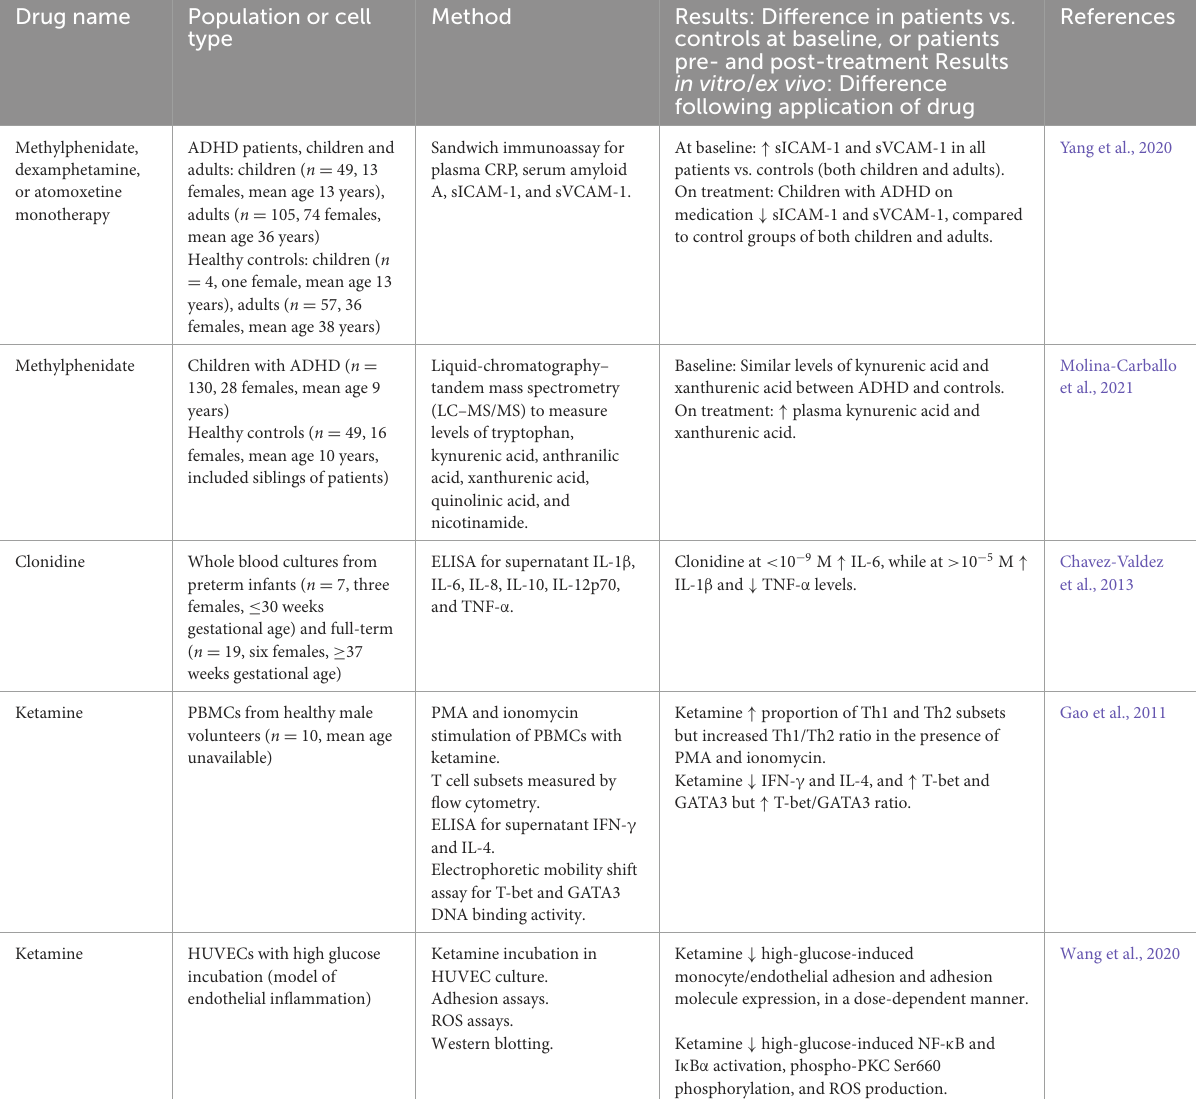
TABLE 6 Anti-inflammatory effects of other drugs in human studies and in studies using in vitro or ex vivo human cells in culture or stimulation assays. Drug name Population or cell Method Results: Difference in patients vs. type controls at baseline, or patients pre- and post-treatment Results in vitro / ex vivo :